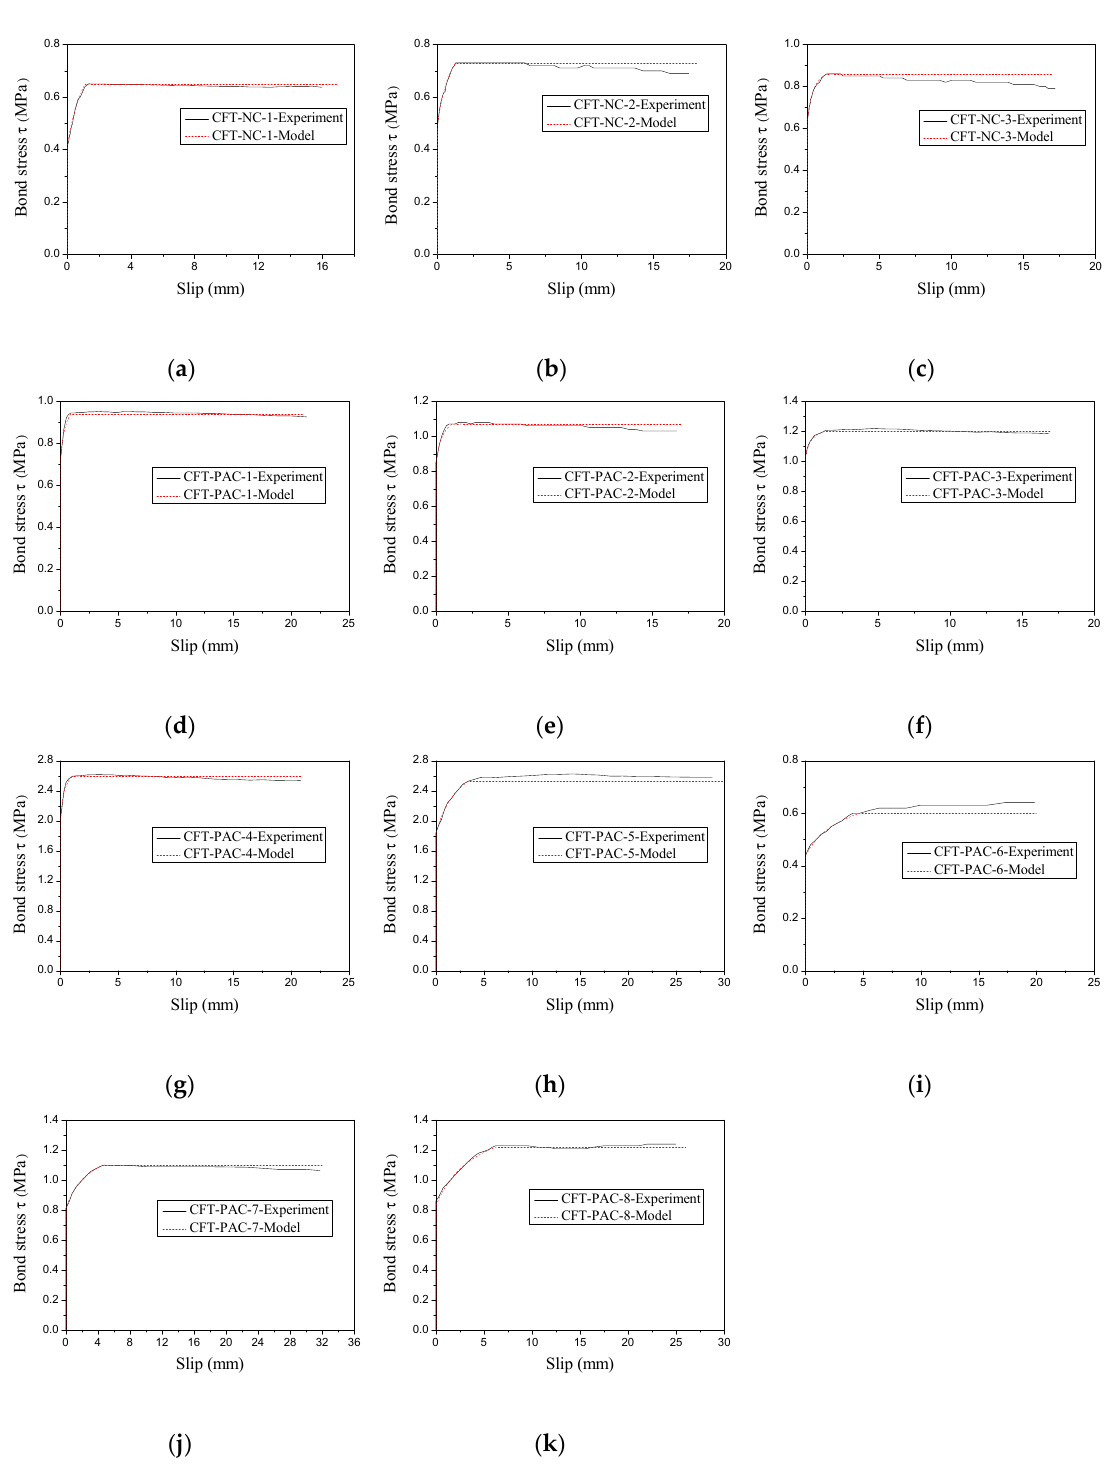
Figure 11. Comparison between testing curves and fitting curves. ( a ) CFT-NC-1; ( b ) CFT-NC-2; ( c ) CFT-NC-3; ( d ) CFT-PAC-1; ( e ) CFT-PAC-2; ( f ) CFT-PAC-3; ( g ) CFT-PAC-4; ( h ) CFT-PAC-5; ( i ) CFT-PAC-6; ( j ) CFT-PAC-7; ( k ) CFT-PAC-8.